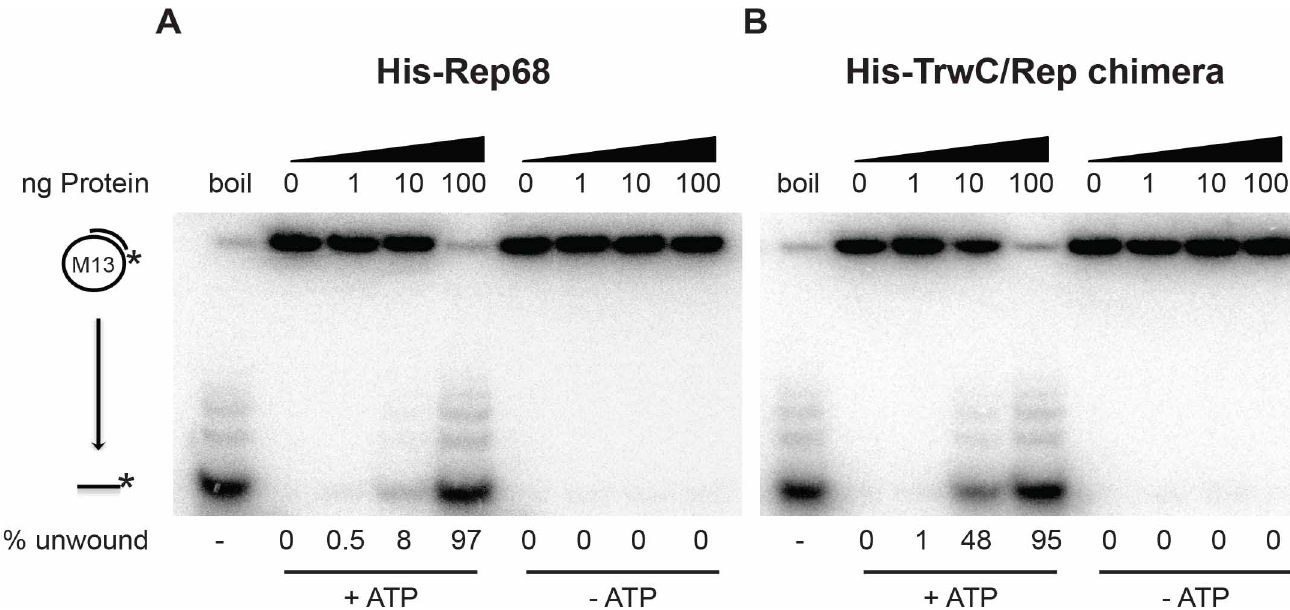
Fig 3. DNA helicase activity of Rep68 and TrwC/Rep. Increasing amounts of Rep68 and TrwC/Rep chimeric protein (0, 1, 10, 100 ng of protein) were assayed in the presence or absence of ATP. “boil” indicates heat-denatured substrate, used as a positive control. Products of the reaction were resolved on 12% native polyacrylamide gels. The diagram to the left of the gel shows the position of the substrate (partial duplex M13 DNA) and unwound labelled ssDNA. The percent of unwound substrate was quantified using the Image Quant TL software. The helicase efficiency percentage is a representative example obtained from 3 independent experiments (n =